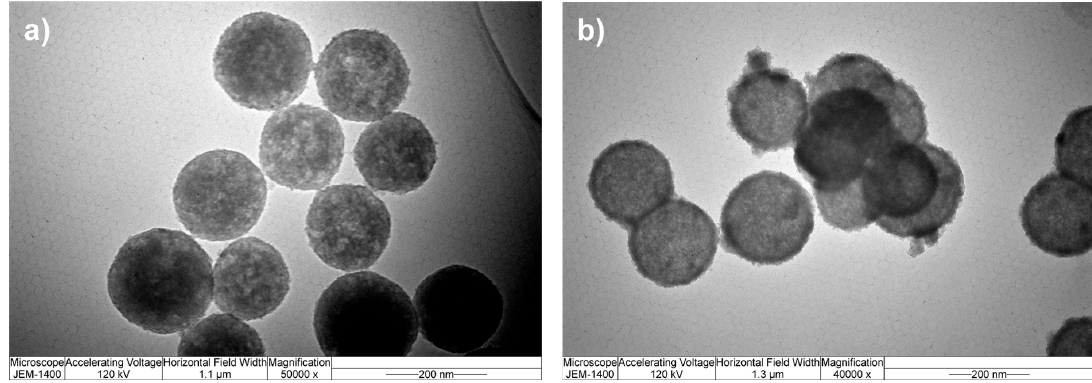
Figure 5. TEM micrographs of silica core/cobalt ferrite shell particles obtained at pH=11 by one step (a) and four step (b) layer deposition.